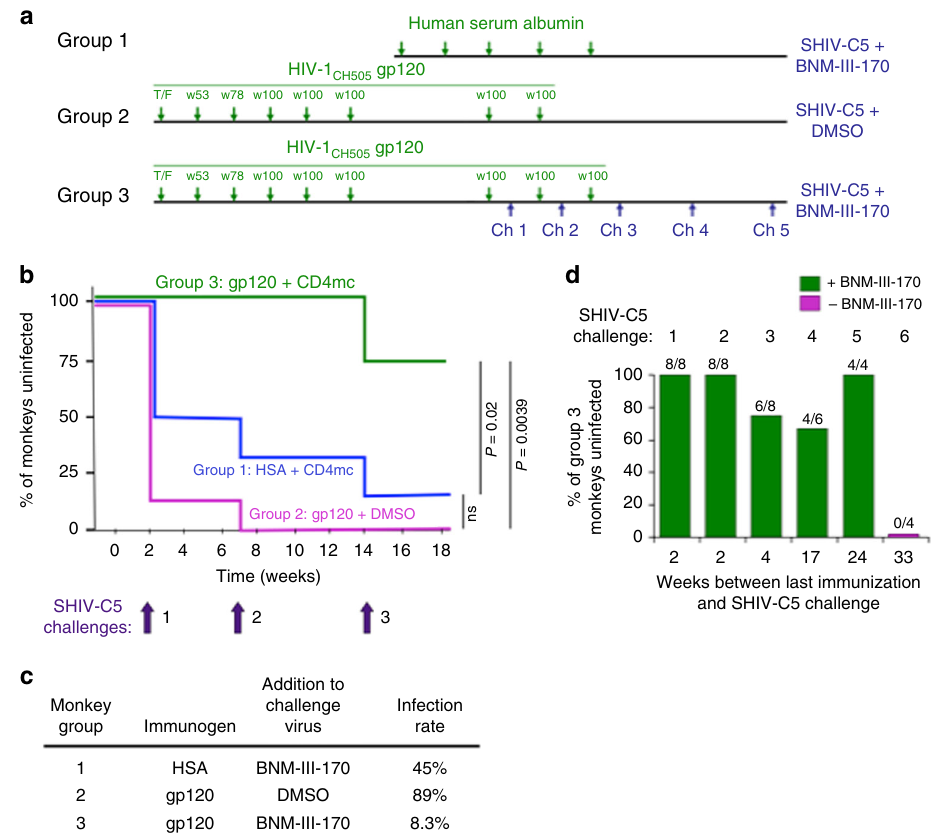
Fig. 4 SHIV-C5 challenges and duration of protective immune responses. a Monkeys were immunized with either human serum albumin (Group 1) or gp120 glycoproteins corresponding to the Envs of the transmitted/founder virus and sequential virus isolates (at weeks 53, 78 and 100) from an HIV- 1 CH505 -infected individual (Groups 2 and 3) (green). Immunized monkeys were challenged with SHIV-C5 mixed with BNM-III-170 (Groups 1 and 3) or DMSO (Group 2) (blue). To accommodate the complete study in this schematic diagram, the time intervals on the horizontal axis are approximated. b Kaplan – Meier curves show the percentage of the monkeys in each group that remained uninfected after three high-dose intrarectal challenges with the heterologous Tier-2/3 transmitted/founder SHIV-C5 39 . The monkeys were boosted with human serum albumin (HSA) (Group 1) or HIV-1 CH505 gp120 (Groups 2 and 3) either two weeks (Challenges 1 and 2) or four weeks (Challenge 3) before the SHIV-C5 challenge. Infection of the Group 2 monkeys occurred at a rate expected for naive monkeys challenged with the same dose (3.5 animal infectious dose (AID 50 ) units) of SHIV-C5 39, 42 . The indicated P values were obtained using the log rank test (ns, not signi fi cant). The rate of infection of the Group 3 monkeys was signi fi cantly lower than that expected if gp120 immunization and BNM-III-170 treatment were simply additive ( P = 0.0186, log rank test). c The results of the three SHIV-C5 challenges shown in ( b ) were used to calculate the infection rate, which is the number of infections/number of exposures. Compared with unvaccinated historical controls 39 , the Jewell bias-corrected relative risk of SHIV-C5 acquisition in the Group 2 monkeys is 0.95 ± 0.24 (95% con fi dence interval). d The percentage of Group 3 monkeys that remained uninfected after SHIV-C5 challenges at different times following the last gp120 immunization is shown. The green bars indicate SHIV-C5 challenges that were conducted in the presence of BNM-III-170 (300 μ M) and the magenta bar indicates a SHIV-C5 challenge performed in the absence of BNM-III-170. Each of the values obtained with BNM-III-170 signi fi cantly differs from that obtained in the absence of the CD4mc ( P < 0.05, one- tailed Fisher exact probability test). The values obtained for the SHIV-C5 challenges performed with BNM-III-170 (green bars) do not signi fi cantly differ from each